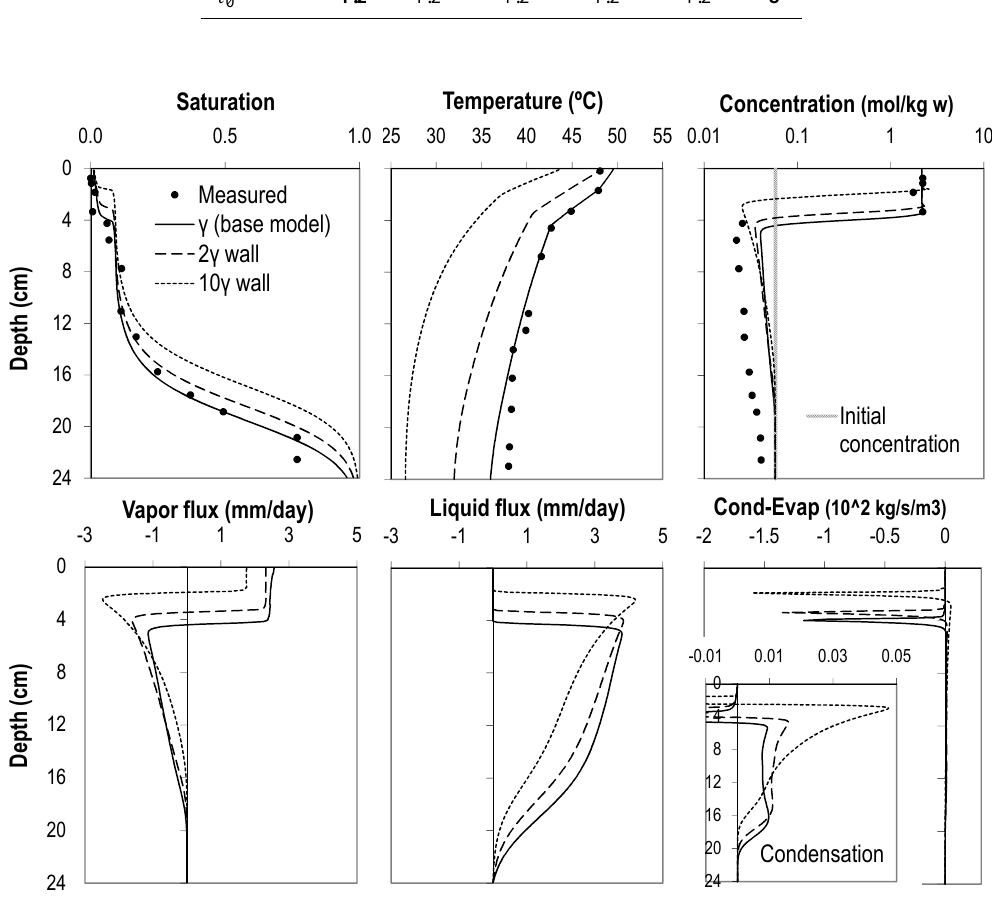
Fig. 6. Analysis of the effect of boundary heat dissipation. Computed profiles of saturation, temperature, concentration, water mass flux, evaporation and condensation after 12